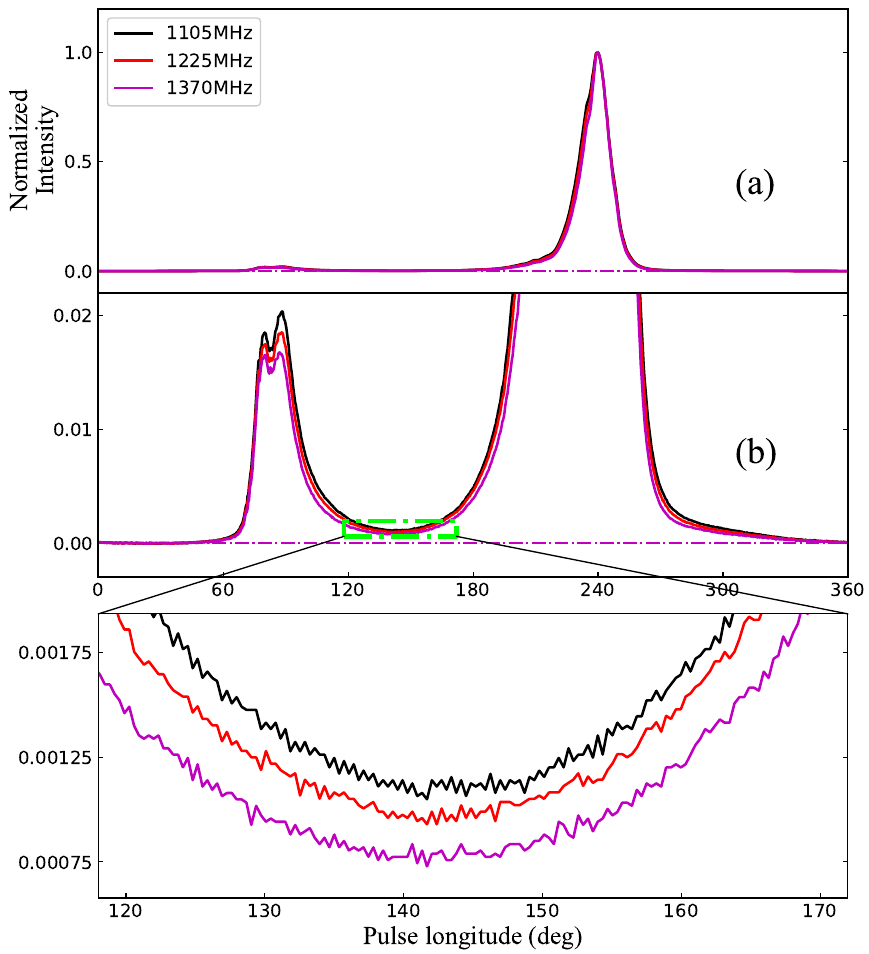
Figure 2. The frequency dependence of the average pulse profile. The average pulse profiles at 1105, 1225, and 1370 MHz are shown in the ( a ) panel with the black, red and magenta lines, respectively. The bottom panel is the extended green square region of panel ( b